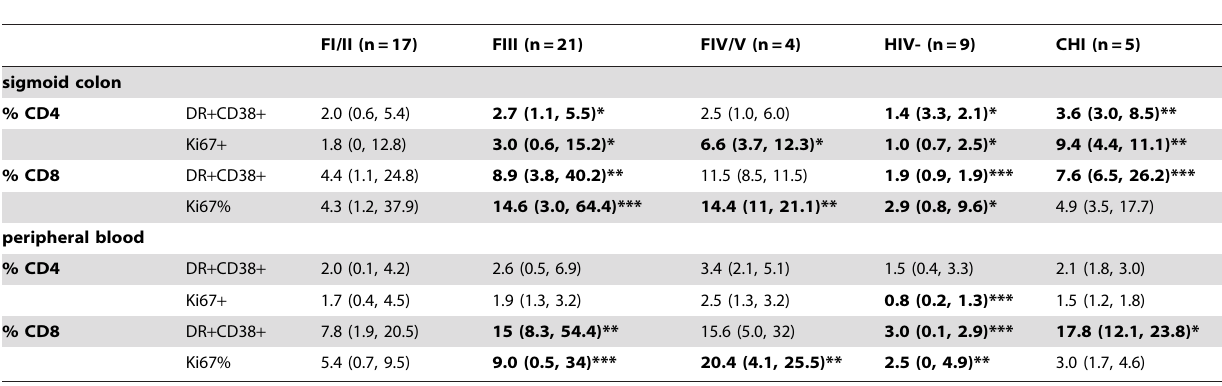
Table 3. Percentage of activated (HLA-DR + CD38 + ) and cycling (Ki67 + ) CD4 + and CD8 + T cells in sigmoid colon and peripheral blood at baseline in HIV-, FI/II, FIII, FIV/V and CHI